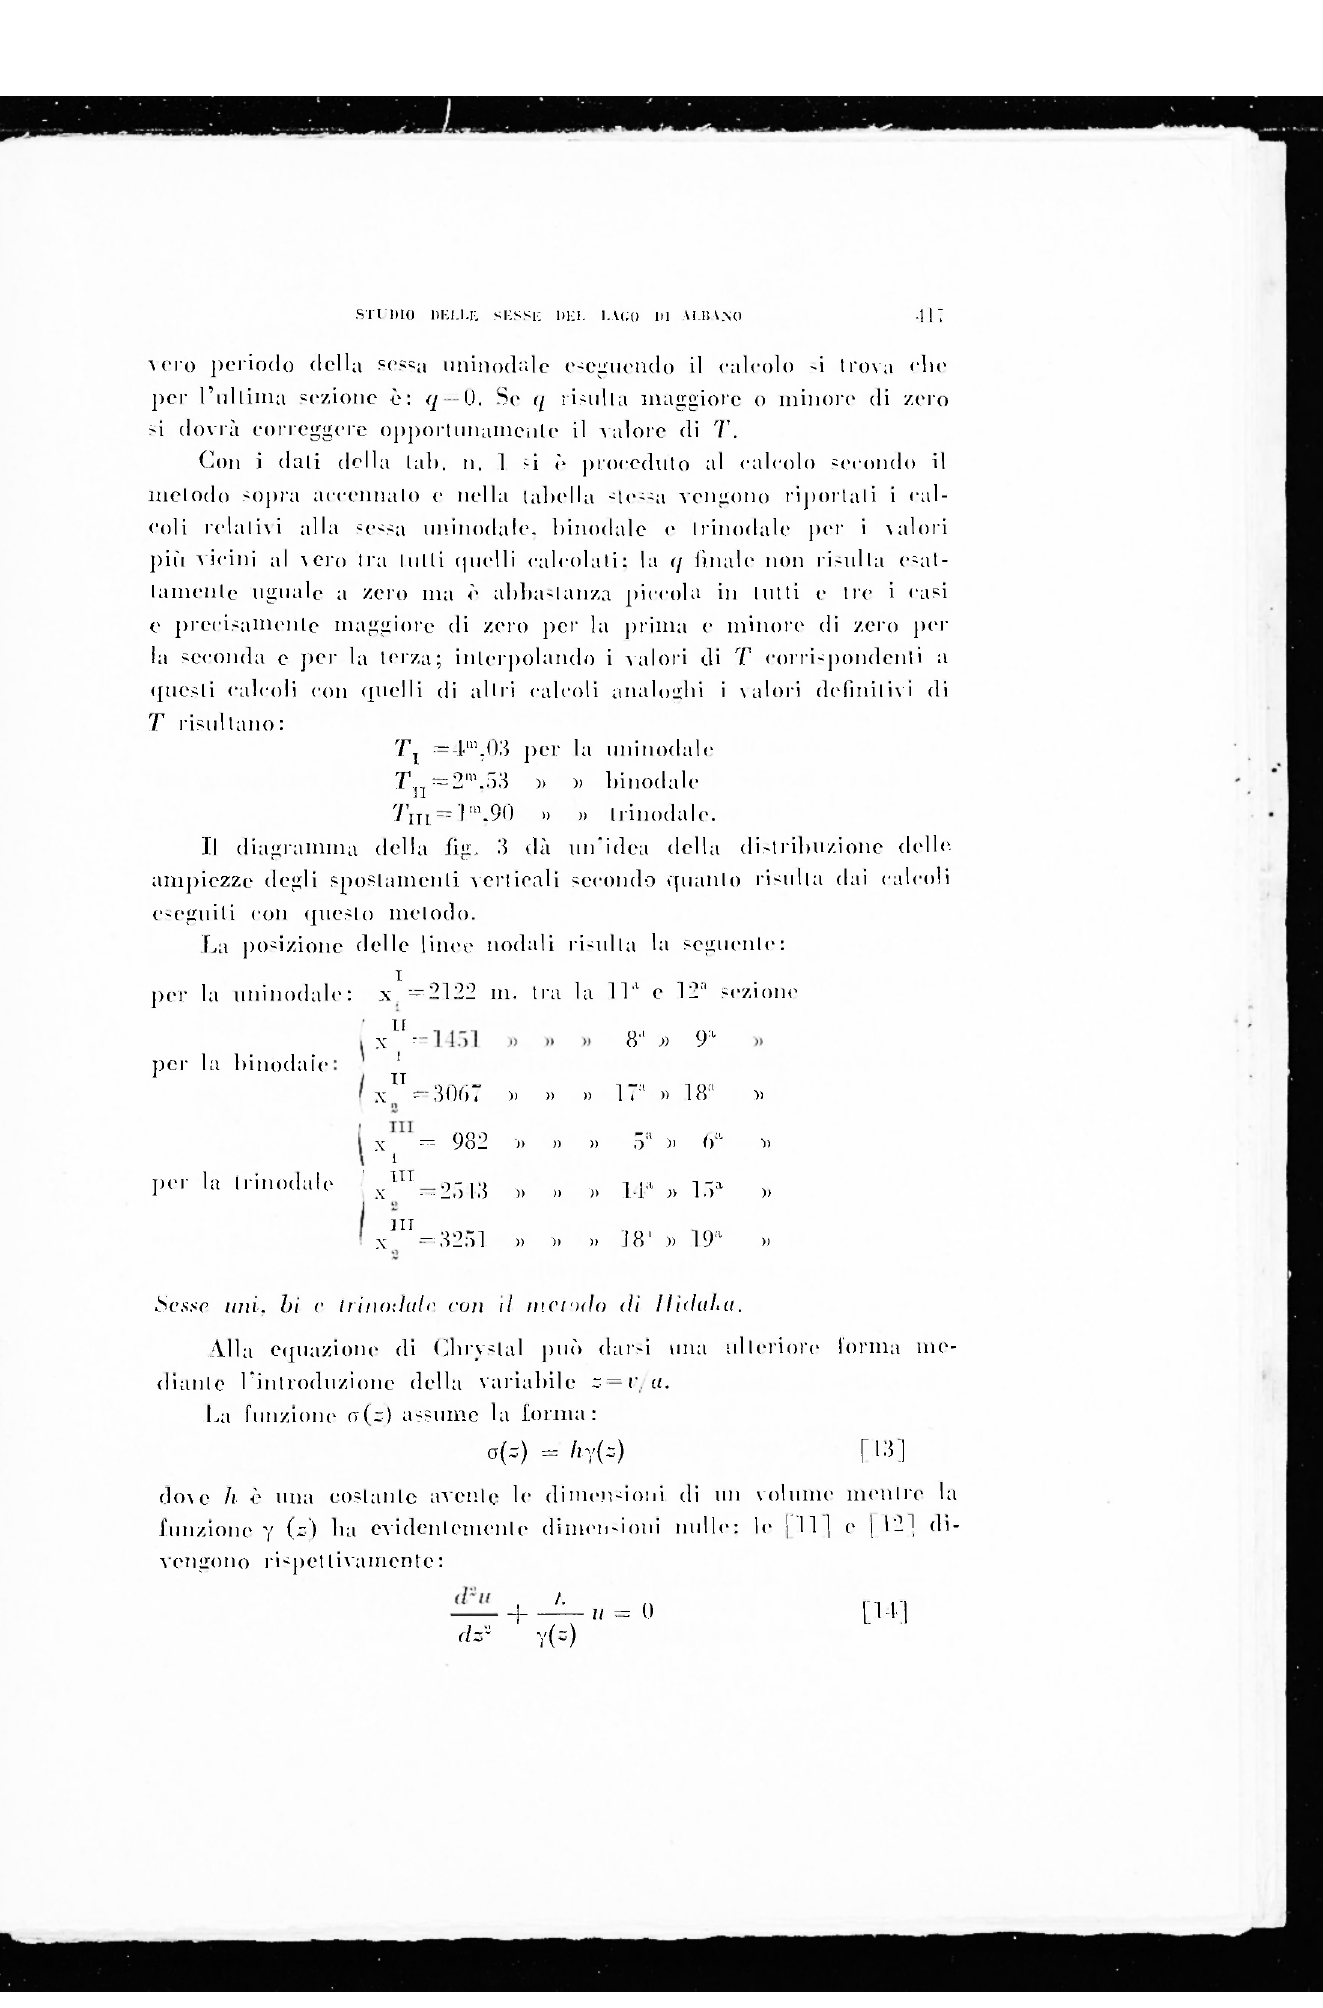
Il diagramma della fig. 3 dà un'idea della distribuzione delle ampiezze degli spostamenti verticali secondo quanto risulta dai calcoli escguiLi con questo